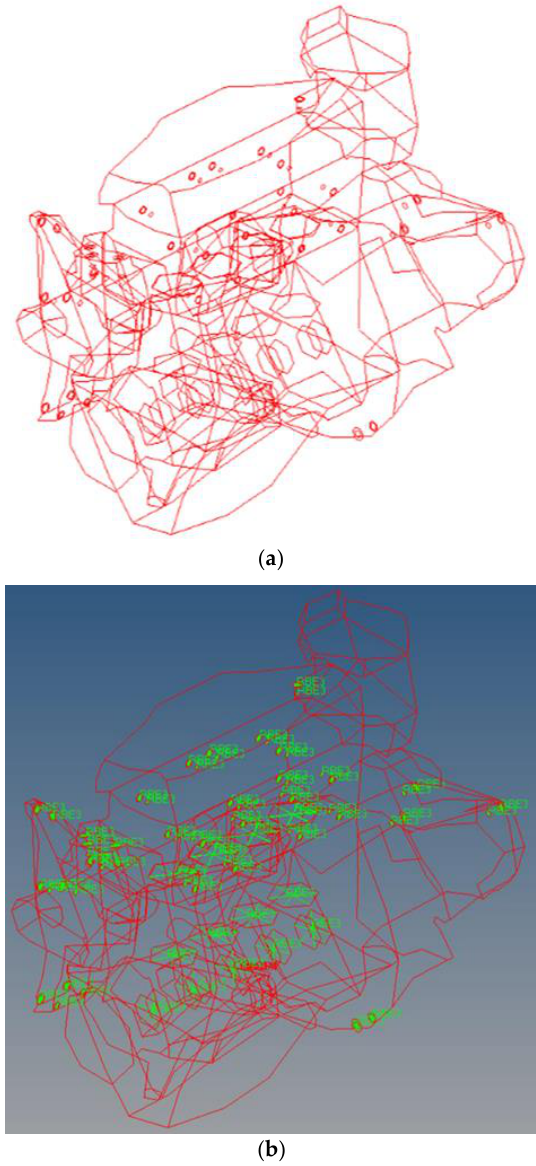
Figure 12. ( a ) Engine model built up with PLOTEL elements; ( b ) highlight of RBE3 elements.